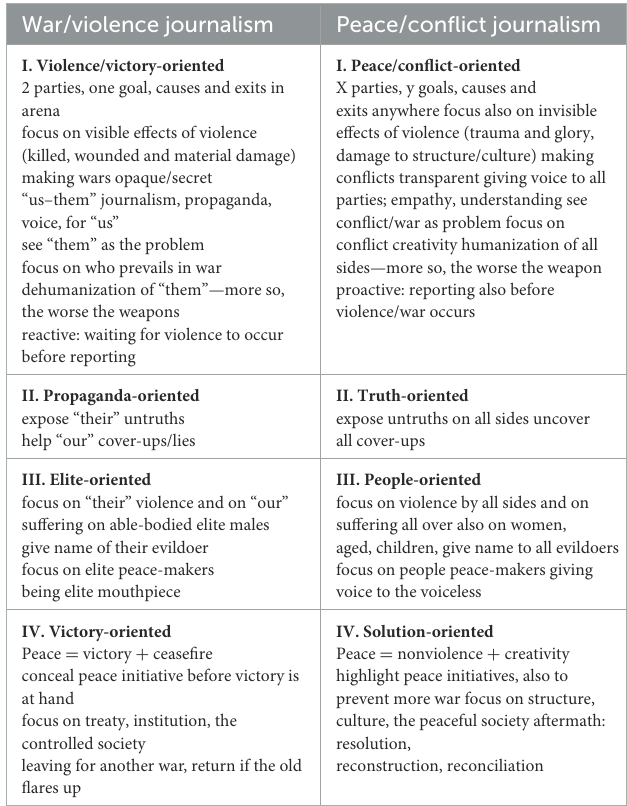
TABLE 1 The Peace Journalism